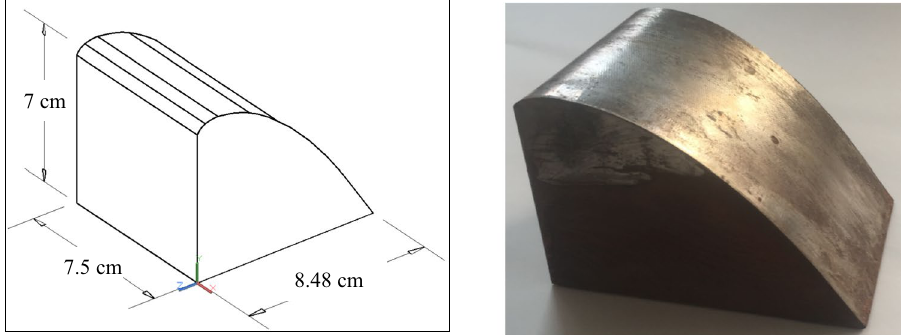
Fig. 7 Shape of the ogee